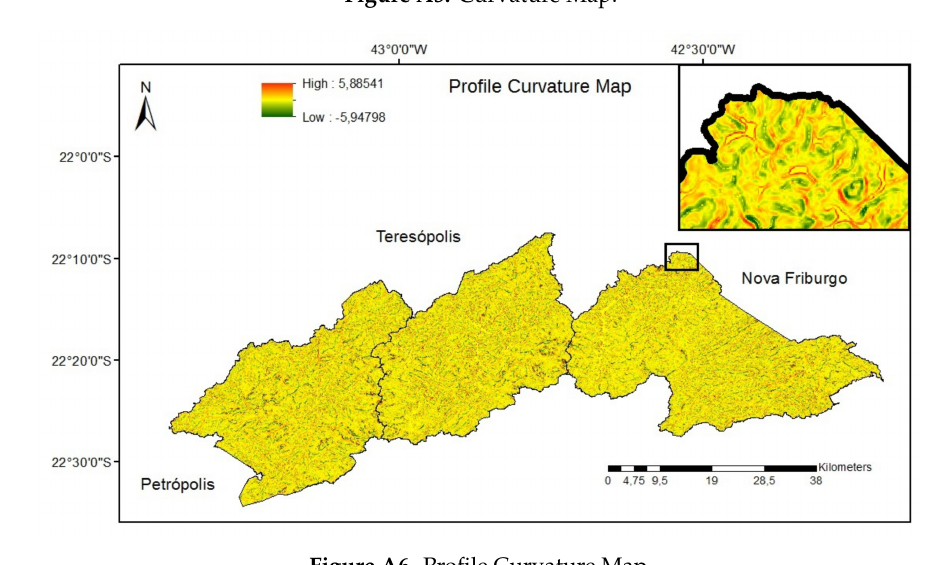
Figure A5. Curvature Map.